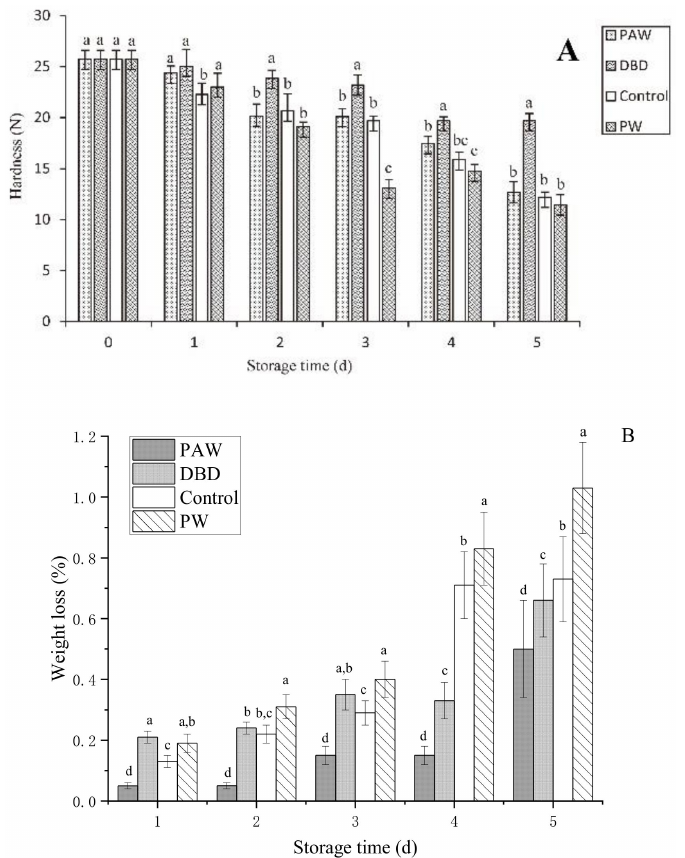
Figure 3. ( A ) The firmness and ( B ) weight loss of the PAW-, DBD-, PW-treated, and control button mushrooms during storage. ANOVA results are represented by letter notation in the bar graphs of panels ( A , B ), where groups marked with different letters differ significantly ( p <